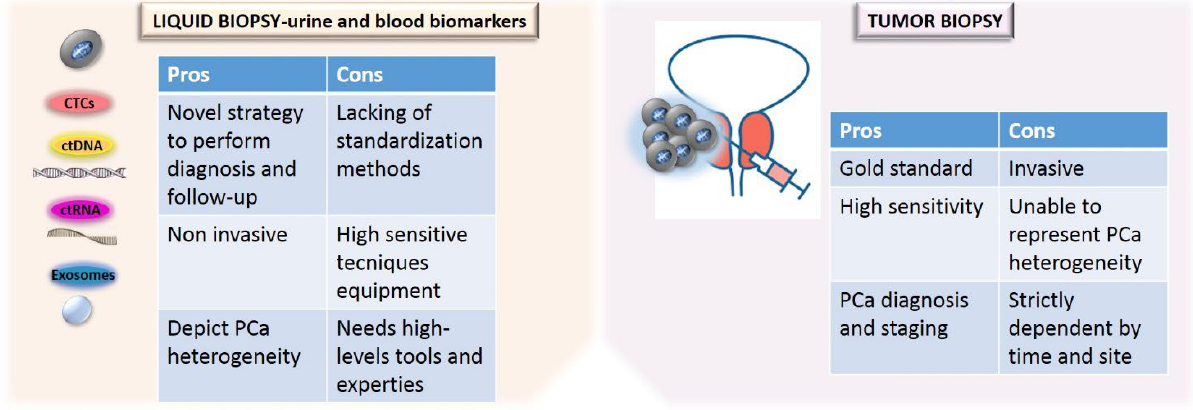
Figure 1. Schematic representation of liquid biopsy composition and application. Credit: Created with BioRender.com (accessed on 3 June 2022).